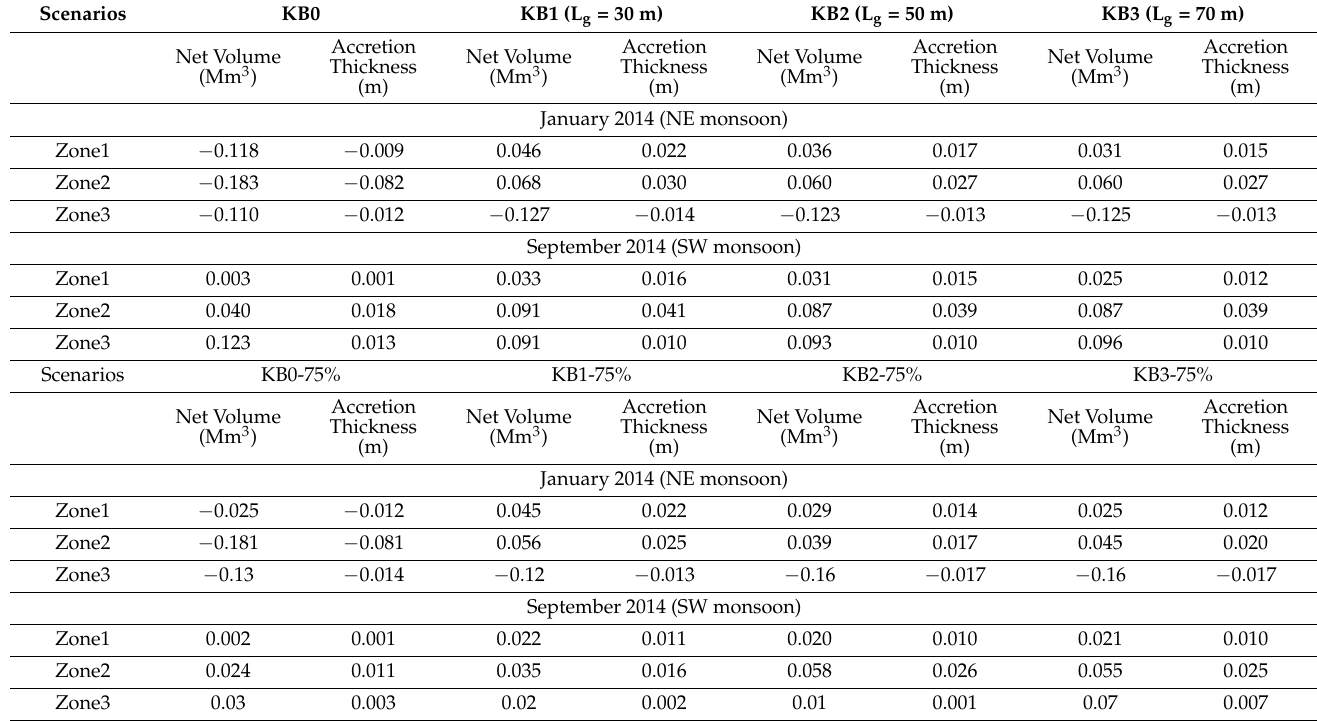
Table 3. Net sediment volume (Mm 3 ) and eroded thickness (m) according to the different breakwater scenarios provided by